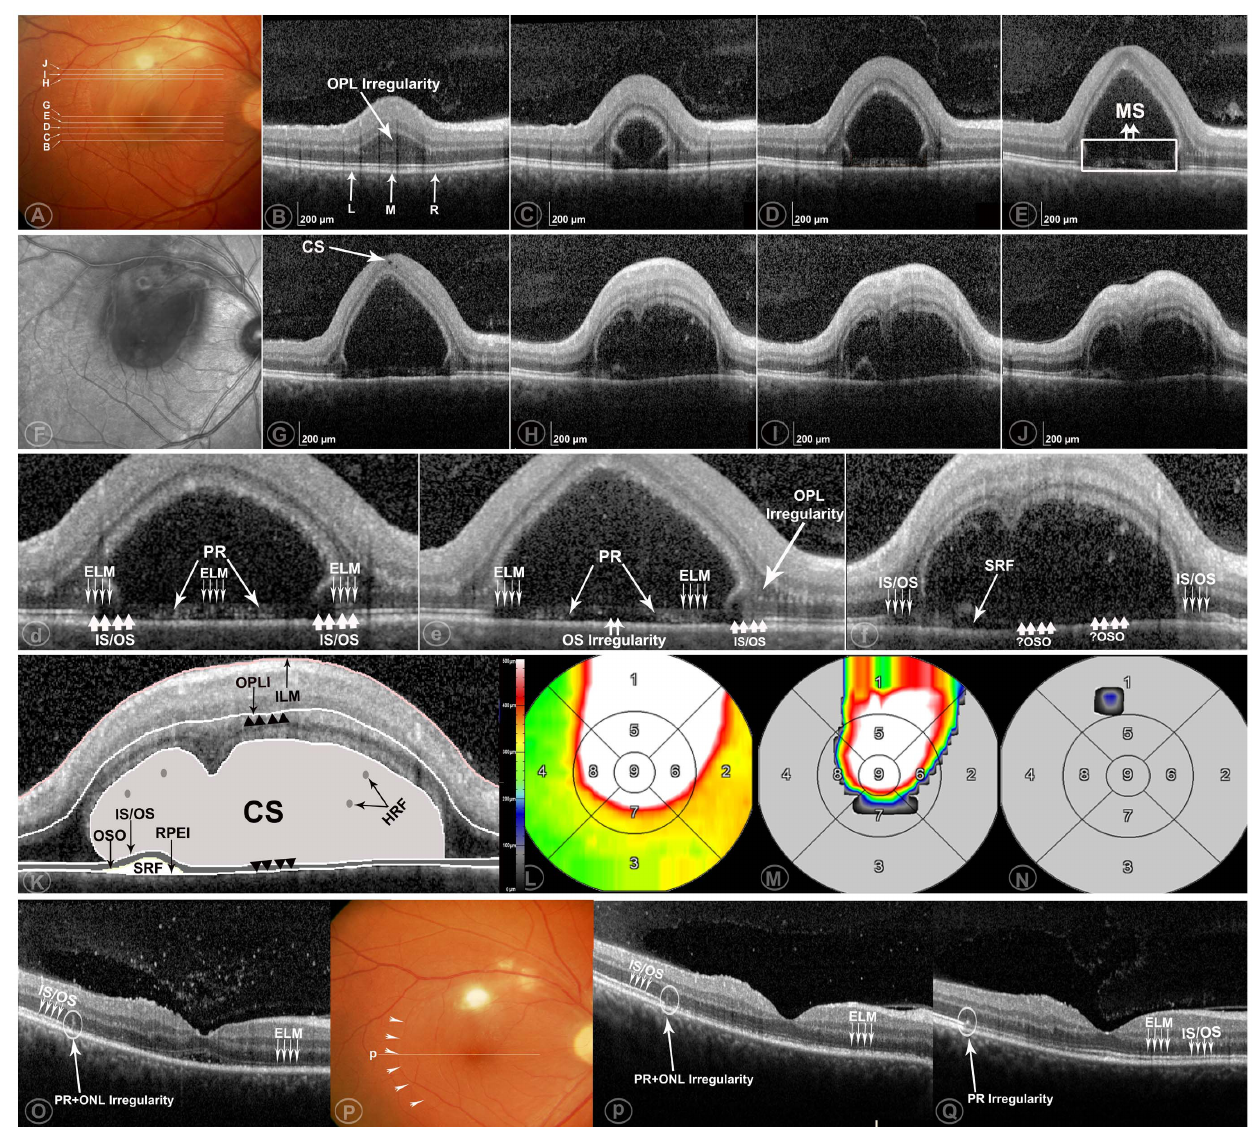
Figure 2. Case example of huge outer retinal cystoid space (CS) as seen on optical coherence tomography (OCT) in a patient with ocular toxoplasmosis. Two days after initial presentation [ A–N ] and at subsequent follow-ups [ P–Q ] (note: [ d–f ] is the magnified view of [ D–F ]). The OCT scans were taken within a 20 u 6 15 u (5.8 6 4.4 mm) area. Distance between adjacent B-scans (B-scans B, C, D, E, G are adjacent; H, I, J are adjacent) was 243 m m. Two days after initial presentation, a membranous structure is seen on OCT. One part of this structure is seen lying over the retinal pigment epithelium (RPE) and forming the floor of the huge outer retinal CS (HORC) [ B–E, G ], while another part is separated from the RPE by an accumulation of subretinal fluid (SRF) [ H–J ]. The line representing the external limiting membrane (ELM) is distinct in the area unaffected by HORC; however, it is continuous with the upper border of the highly reflective membranous structure in the area affected by HORC [ D–F, d–f ]. The photoreceptor inner segment/outer segment junction (IS/OS junction) is distinct in the area unaffected by HORC, becoming less distinct in the area with overlying HORC. Photoreceptor IS/OS disruption and outer segment (OS) irregularity is also observed [ E, G–J, e–f ]. The retinal thickness map [ L ], mean HORC height map [ M ], and the mean maximum SRF height map [ N ], are shown for the Early Treatment Diabetic Retinopathy Study (ETDRS) grid. The presumed interpretation of the structural changes are also shown (the outer retina is the area between the black arrows) [ K ]. OCT images obtained 15 days later demonstrate that the HORC is no longer present [ O ]. Punctate hyperreflective foci are seen in the posterior vitreous overlying this area. The ELM is almost completely distinct in all B-scans. In contrast, the photoreceptor IS/OS junction is still not fully distinct. Irregularity of the PR and outer nuclear layer (ONL) presenting as local hyperreflective foci is seen at the previous junction of the HORCs with the normal retina. This feature persists at subsequent visits [ P–Q ]. A hyporeflective space between the ELM or presumed IS/OS and inner boundary of the RPE is observed subfoveally, with possible hyperreflective material above RPE. Subsequent OCT images were obtained approximately one month [ P ] and two months [ Q ] following initial presentation. No HORC or SRF is seen at these points. The photoreceptor IS/OS junction is more clearly seen, with a thickness value of 68 m m [ Q ].